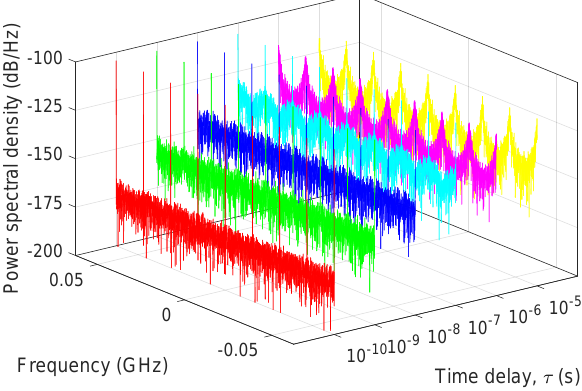
Figure 5. Zoom of the power spectral density of a demodulated OFDM signal as a function of the chromatic dispersion